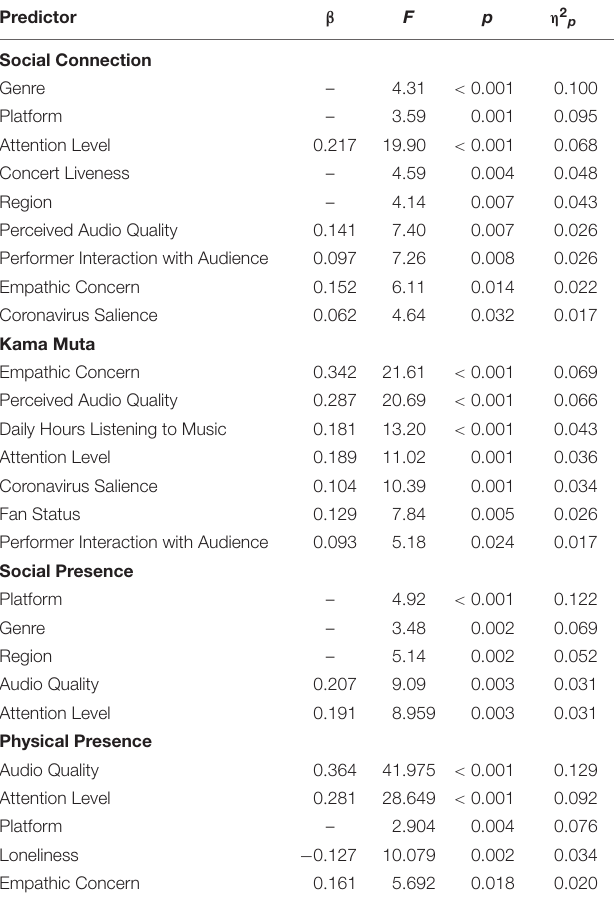
TABLE 1 | Significant predictors and effect size estimates for the ANCOVAs in order of descending effect size (partial eta-squared) explaining 1) social connection, 2) kama muta , 3) social presence, and 4) physical presence.